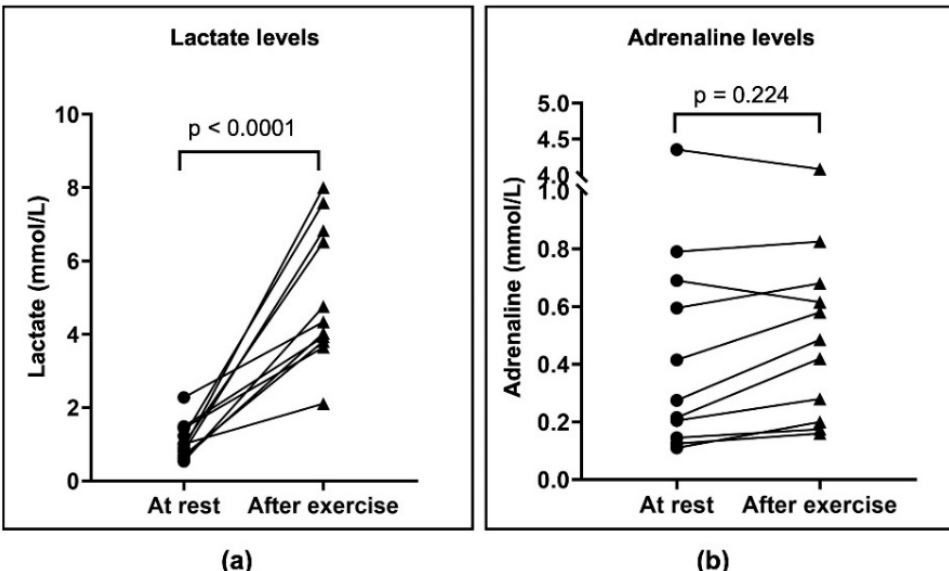
Figure 5. Lactate and plasma adrenaline concentrations were measured in blood samples obtained prior to and directly after exercise intervention. ( a ) There was a significant increase in lactate concentrations when comparing resting (1.09 ± 0.50 mmol/L) and post-exercise values (5.05 ± 1.88 mmol/L) using a paired t -test ( p < 0.0001). ( b ) There was no significant change in adrenaline concentrations when comparing resting and post-exercise values, despite adrenaline concentrations showing high variability within the tested group. Low adrenaline concentrations of 0.2 nmol/L (nanomole per liter) are in line with available data in healthy children [42]. mmol/L, millimole per liter; nmol/L, nanomole per liter.